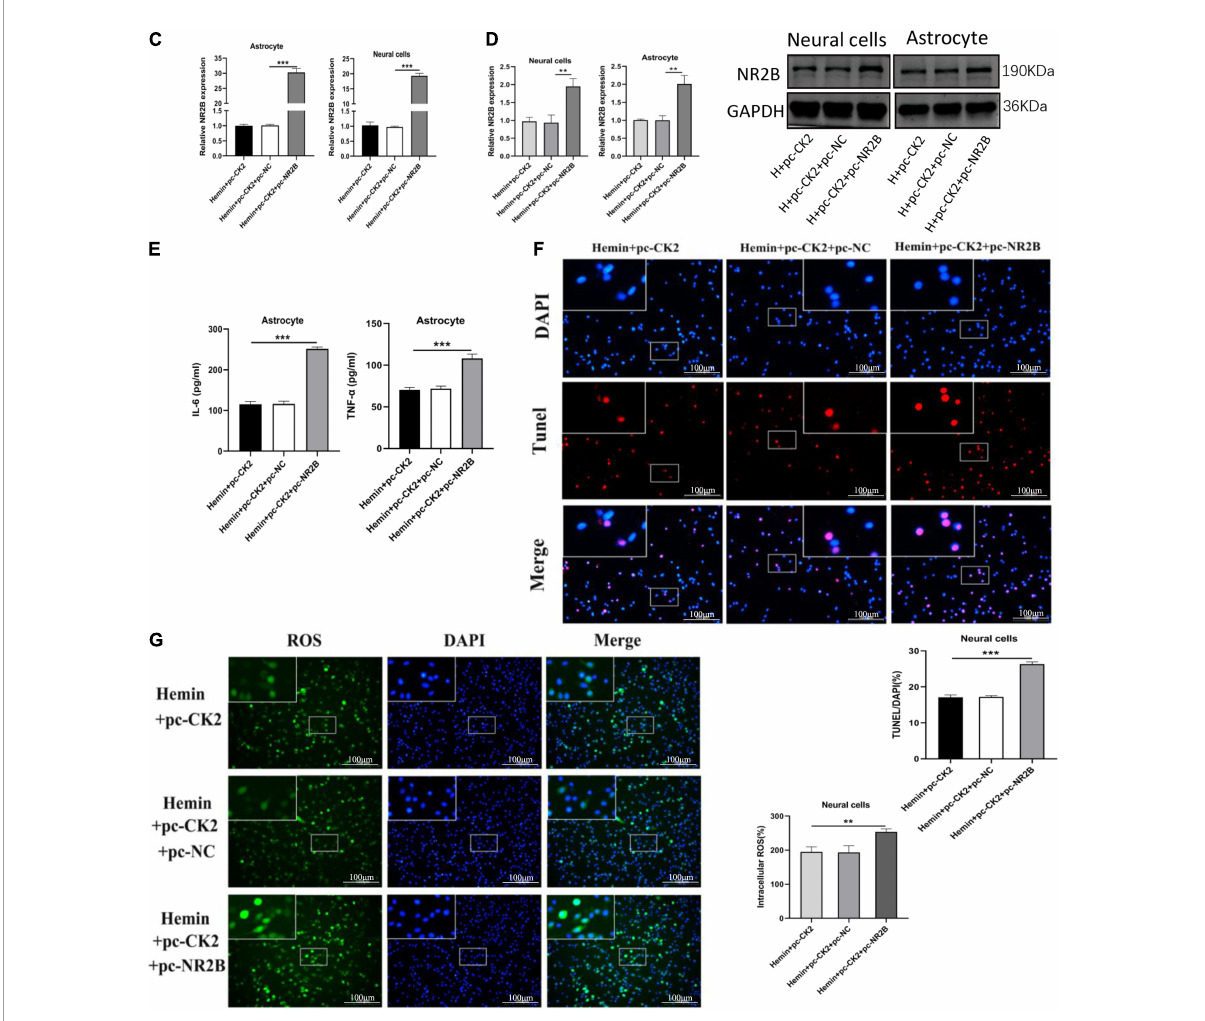
FIGURE7 CK2 overexpression reduced cell inflammation, apoptosis and oxidative stress through changing NR2B phosphorylation level and NR2B-PSD95 complex. pc-NR2B was transfected into Hemin + pc-CK2 treated neurons and astrocytes. (A) Expression of NR2B, NR2B phosphorylation sites S1480, S1303, and Tyr1472 were determined in cells using Western blot. (B) Representative gel images and quantification of co-immunoprecipitation (co-IP) show the level of NR2B-PSD95 complex in cells. (C) Expressions of NR2B in cells were detected using RT-qPCR. (D) NR2B expression was detected using Western blot. (E) Levels of TNF- α and IL-6 in astrocytes were detected using ELISA. (F) Cell apoptosis was measured using TUNEL assay. (G) Content of ROS was determined by fluorescence probe DCFH-DA. The cell experiment was repeated three times independently. Data were expressed as mean ± standard deviation. ** p < 0.01, *** p < 0.001, **** p <